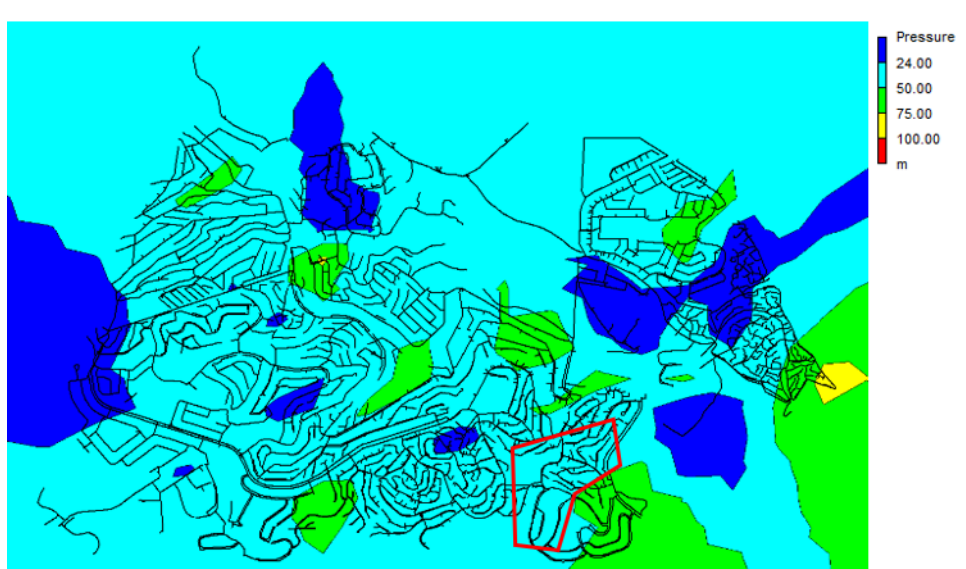
Figure 7. Pressure head reduction due to PAT-1, PAT-2 and PAT-4 installed in the WDN. (Changes outlined in